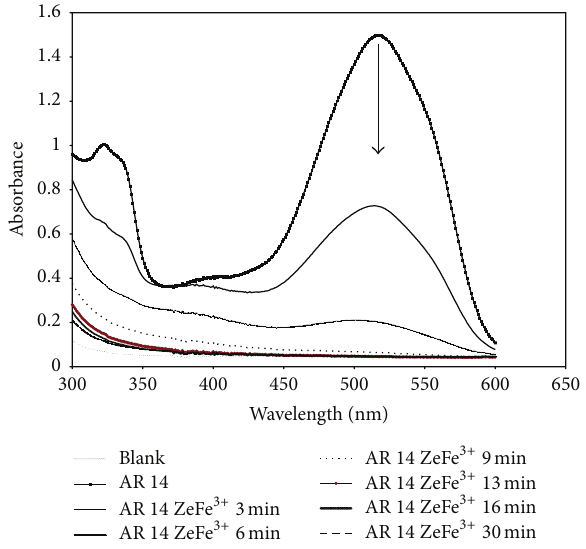
Figure 5: UV-Visible spectra changes of Acid Red 14 during Fe(III)- Y zeolite/H 2 O 2 process.